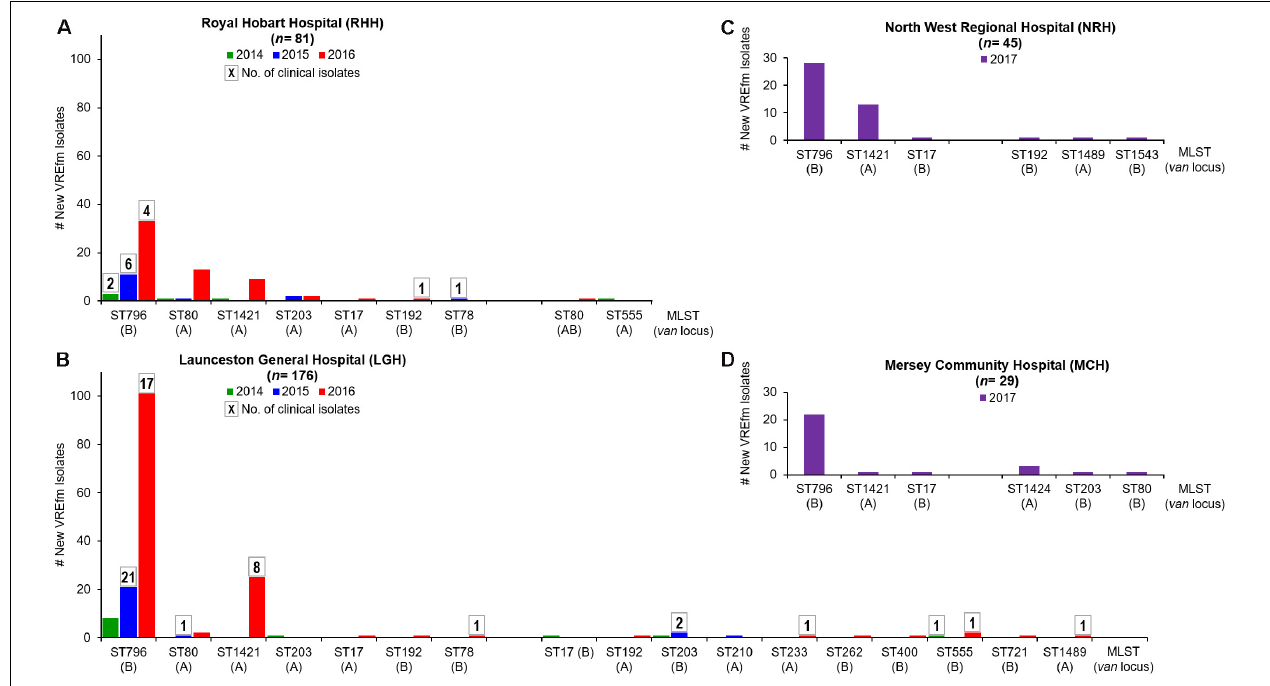
FIGURE 1 | Multi-Locus Sequence Types (MLST) of vancomycin-resistant Enterococcus faecium (VREfm) isolates collected at Tasmania’s four acute public hospitals: (A) Royal Hobart Hospital (RHH) and (B) Launceston General Hospital (LGH) from 2014 to 2016; (C) North West Regional Hospital (NRH) and (D) Mersey Community Hospital (MCH). The MLST (and vancomycin-resistance locus) of the VREfm isolates were determined in silico from whole genome sequence data. Boxed numbers above histograms represent the number of new clinical VREfm isolates collected within each sequence